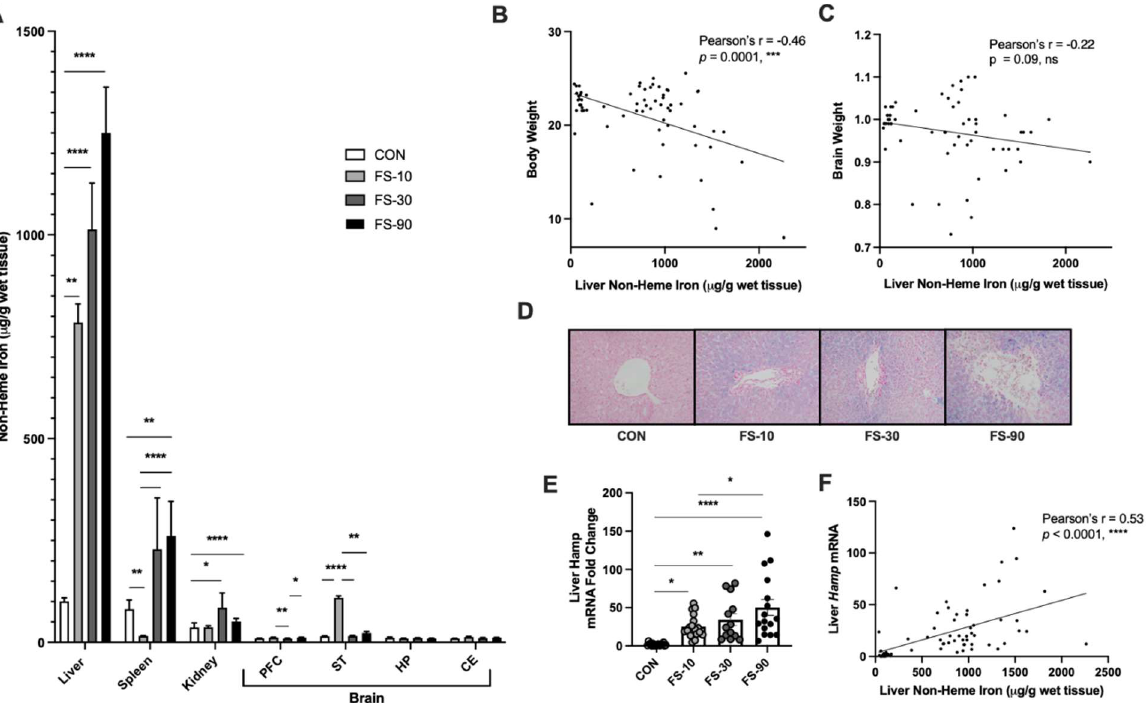
Figure 2. Liver iron loading and hepcidin expression increased with iron dose . ( A ) Tissue non-heme iron concentration on PD 10 following 8 days of FS supplementation; PD 2–9. Data for each tissue (n = 14–18/group, 3 litters/group) are represented as mean ± SEM. ( B ) Correlation analysis of liver non-heme iron concentration vs. PD 10 body weight and ( C ) brain weight. ( D ) Representative images liver sections stained with Perls’ Prussian blue (n = 6 per group). ( E ) Fold-change in liver Hamp mRNA expression, assessed by RT-qPCR. Biological replicates (n = 13–18/group, 3 litters/group) are shown as individual data points with mean ± SEM. ( F ) Correlation analysis of liver non-heme iron concentration vs. liver Hamp expression. p -value summary: *, p < 0.05; **, p < 0.01; ***, p < 0.001; ****, p < 0.0001; ns = non-significant.